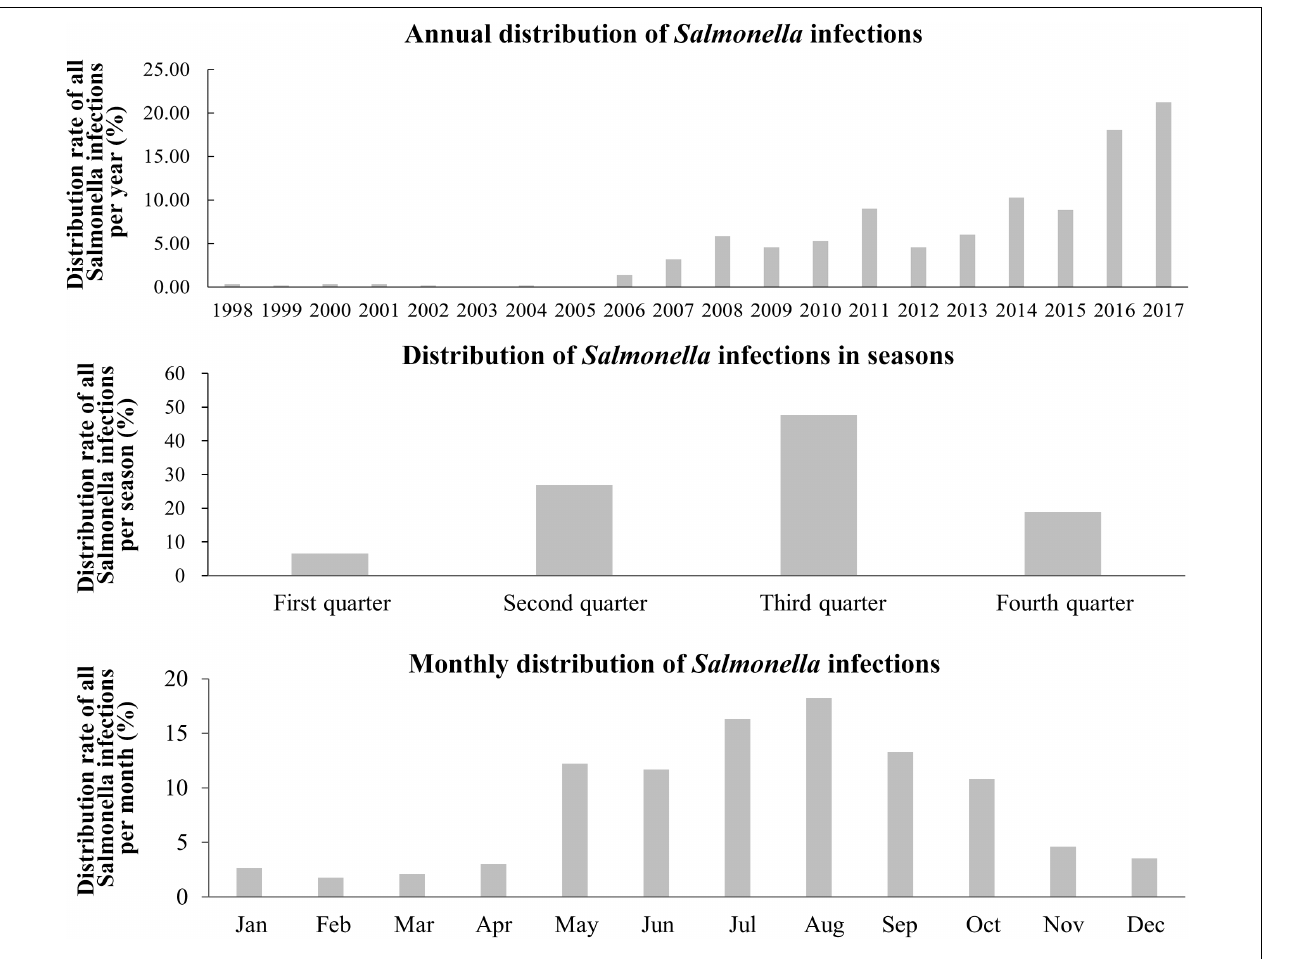
Frontiers in Microbiology |